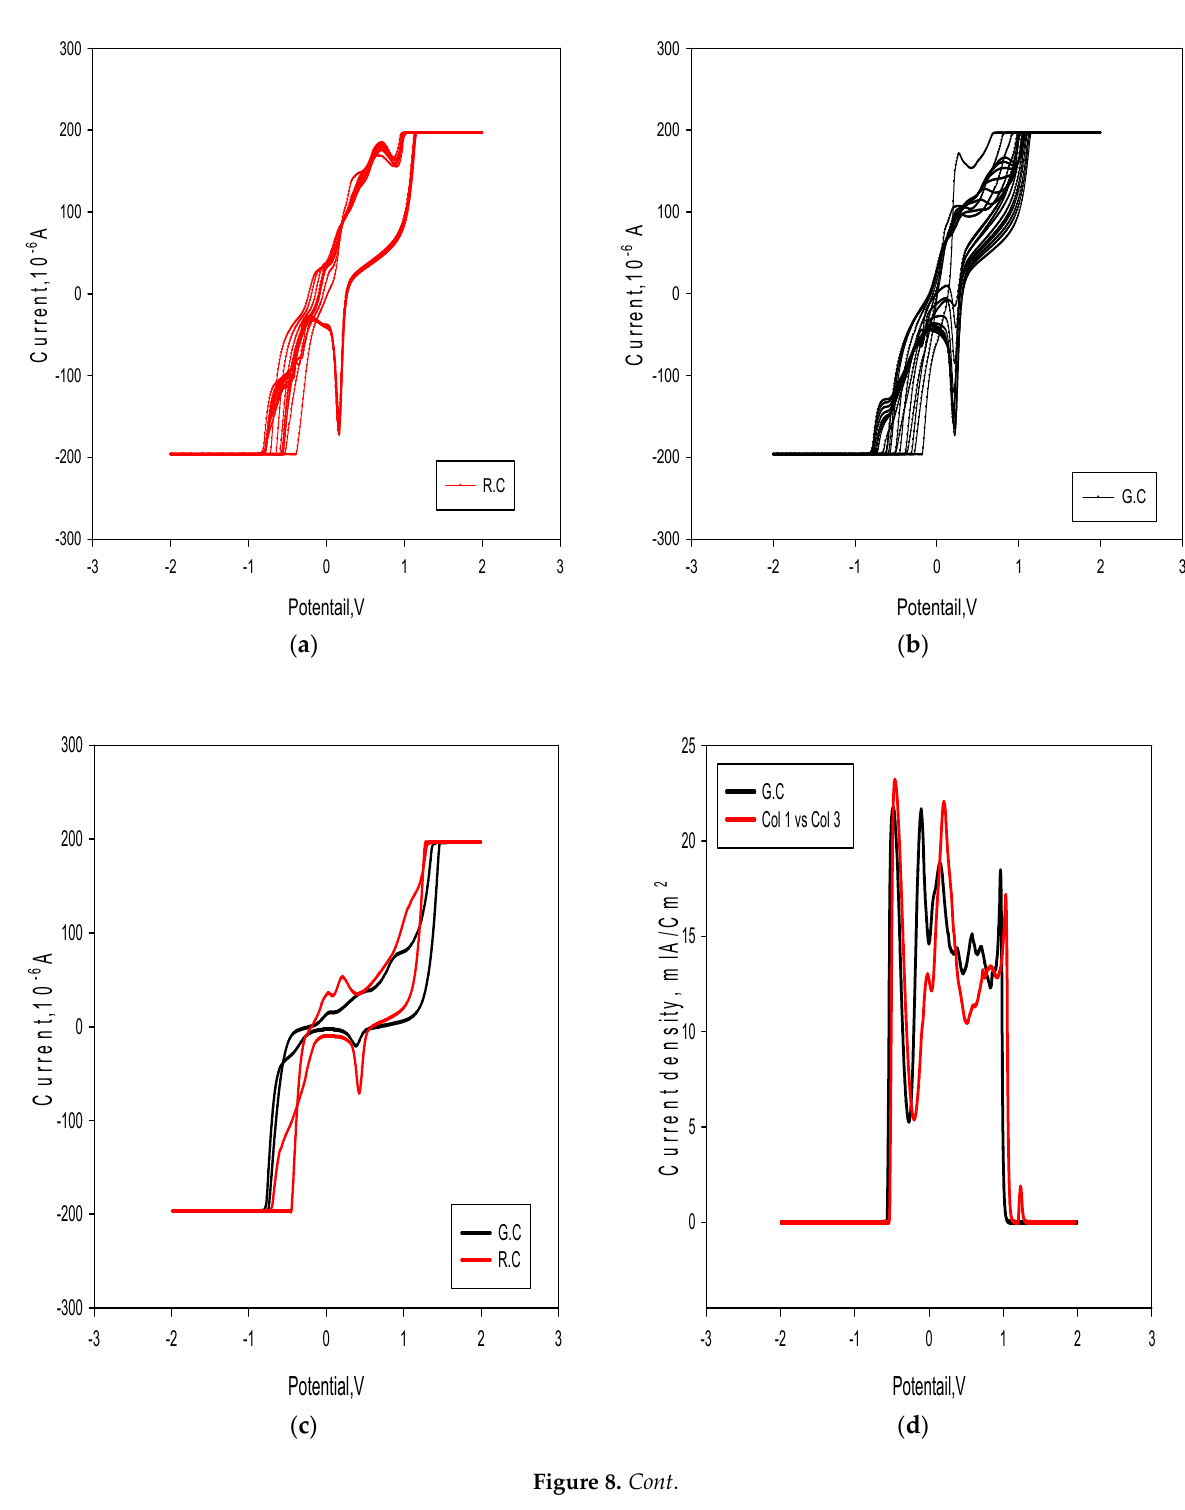
Figure 8c). With an increase in the scan rate, the distances between the peaks increased for both the anode and the cathode, owing to the higher limit of the ion diffusion rate required to satisfy electronic neutralization during the redox reaction. The RC extract outperformed the GC extract (see Figure 8d). The CV curves have similar shapes for both extracts, implying that both the extracts possessed reversibility as well as faster redox reactions, which is consistent with the results in the literature [64–66].